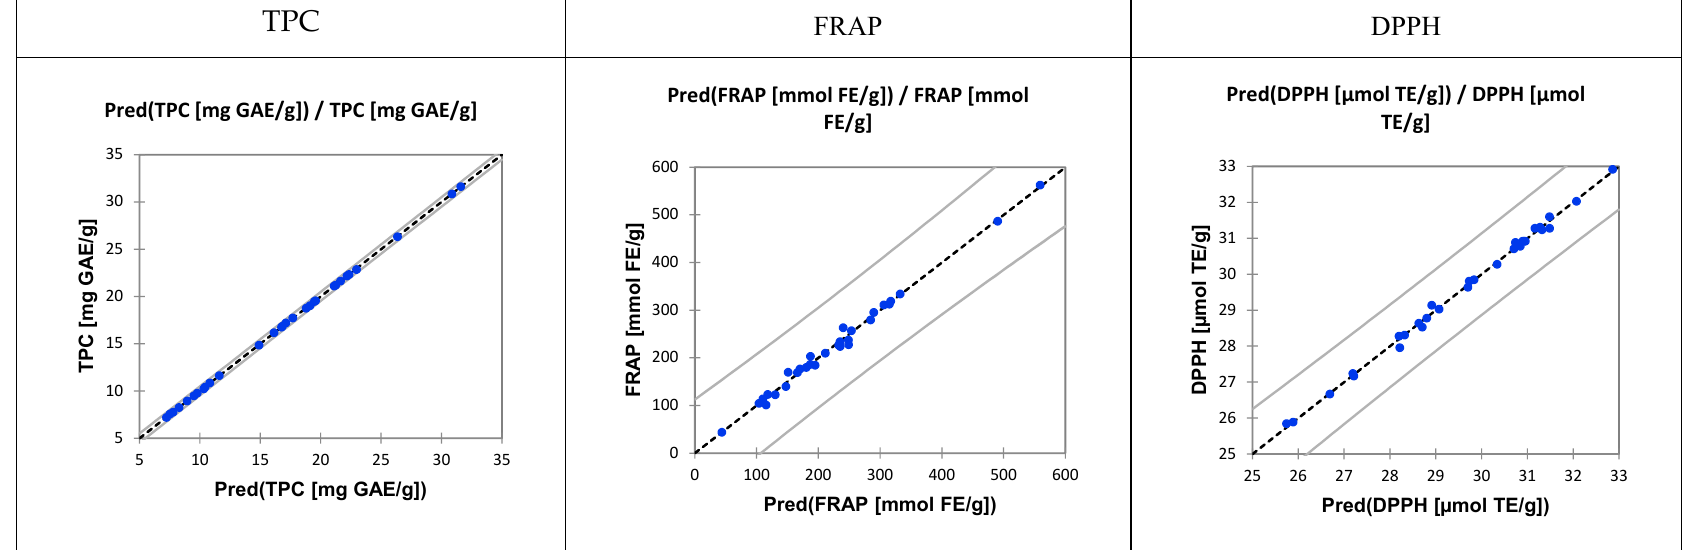
Figure 5. Control chart for predicted and experimental data of analyzed samples, using principal component regression (PCR) models.